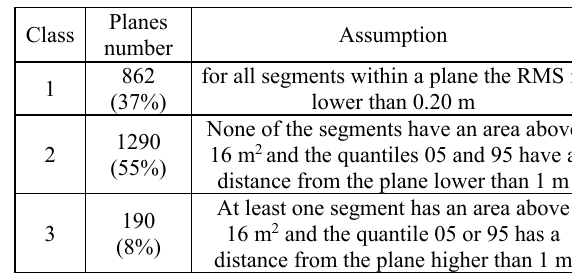
Table 2. Results and assumptions of planes classification into 3 classes for the Warsaw test area (solid models).